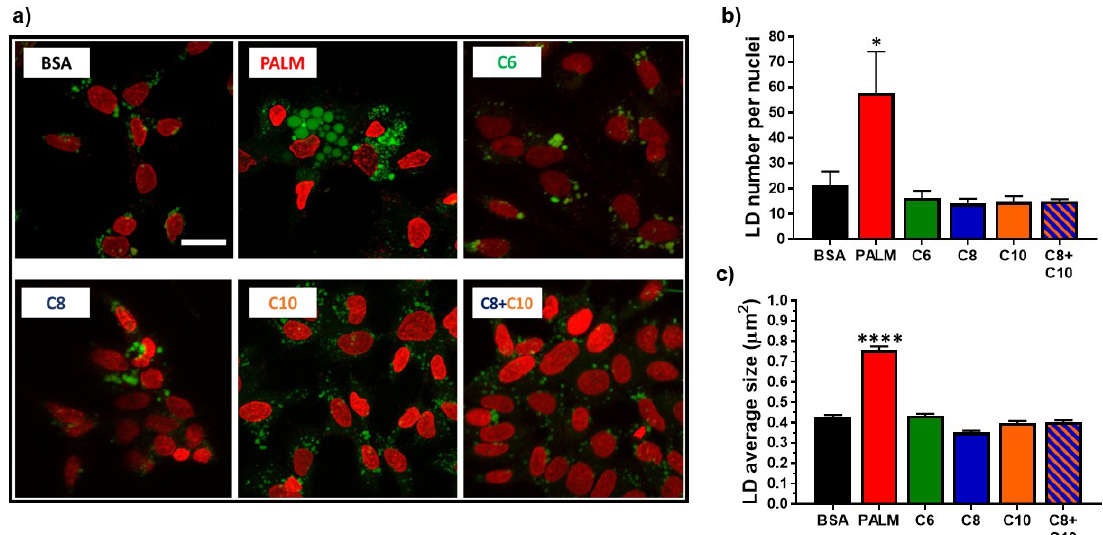
Figure 2. Effect of fatty acids on HepG2 intracellular lipid storage. HepG2 cells were treated 24 h with 0.25 mM PALM, C6, C8, C10, a C8 + C10 equimolar mix, or vehicle control (BSA). ( a ) Representative images of LD staining (green). Cell nuclei are shown in red. Scale bar = 20 μm. ( b ) LD number per cell nuclei ( n = 4). ( c ) Average LD size in μm 2 ( n = 4). * p ‐value < 0.05, **** p ‐value < 0.0001 versus BSA control.